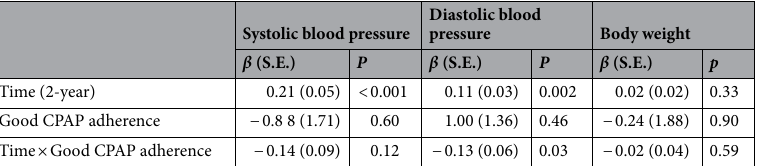
Diastolic blood pressure